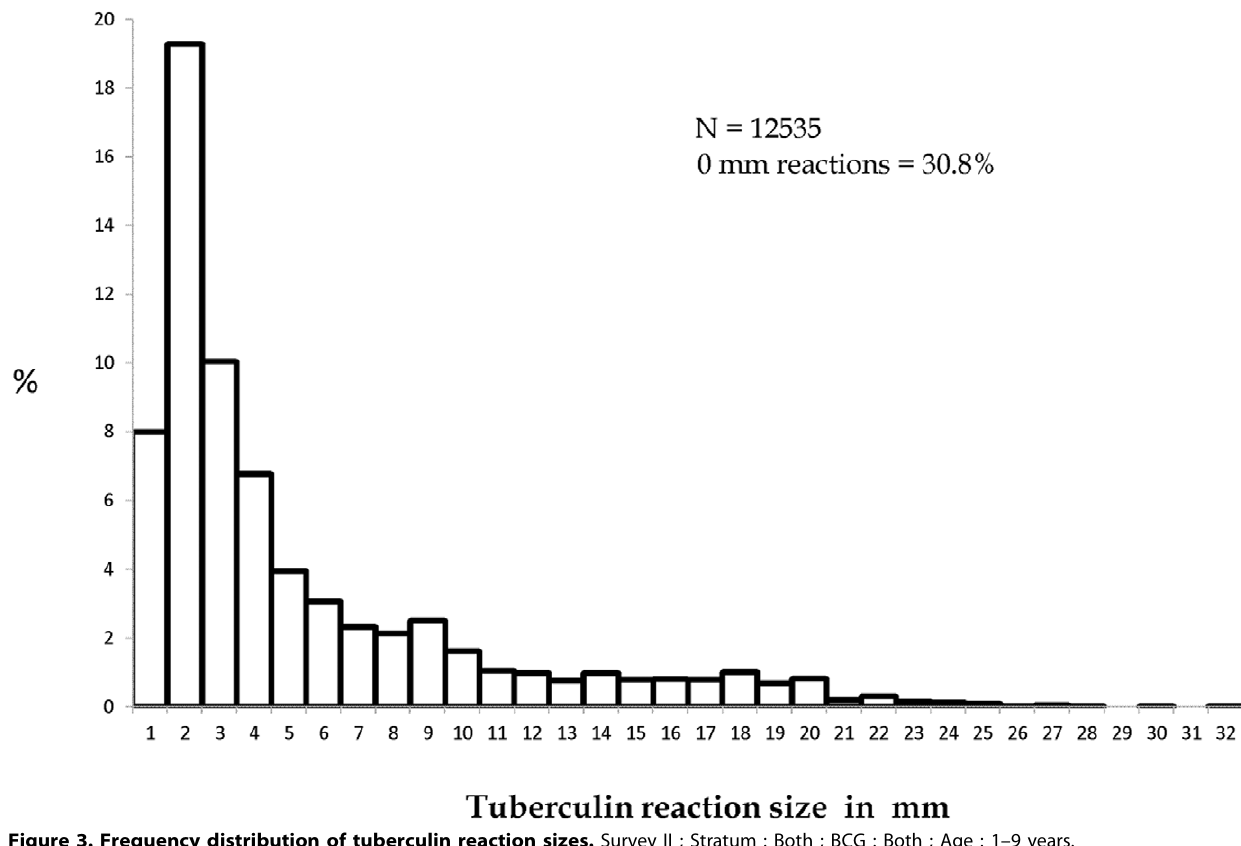
Figure 3. Frequency distribution of tuberculin reaction sizes. Survey II ; Stratum : Both ; BCG : Both ; Age : 1–9 years.